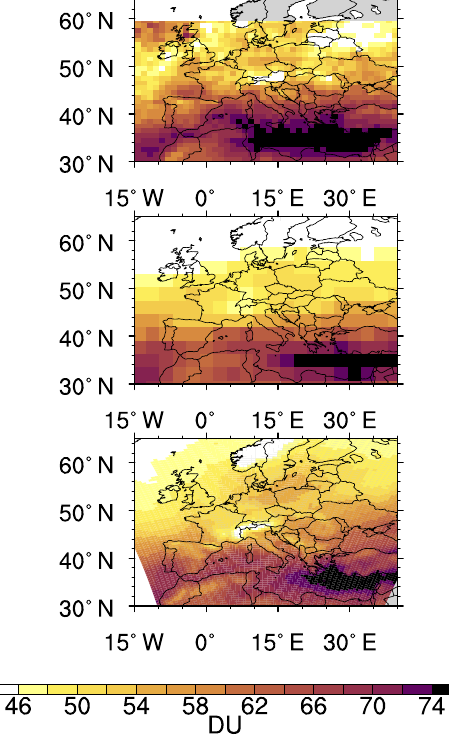
Figure 3. Tropospheric ozone columns in Dobson units (DU) of OMI (top), EMAC (middle) and CM50 (bottom) for June 2008. Please note that the OMI values are scaled with 1.45 for a better comparability (allowing the same colour bar).